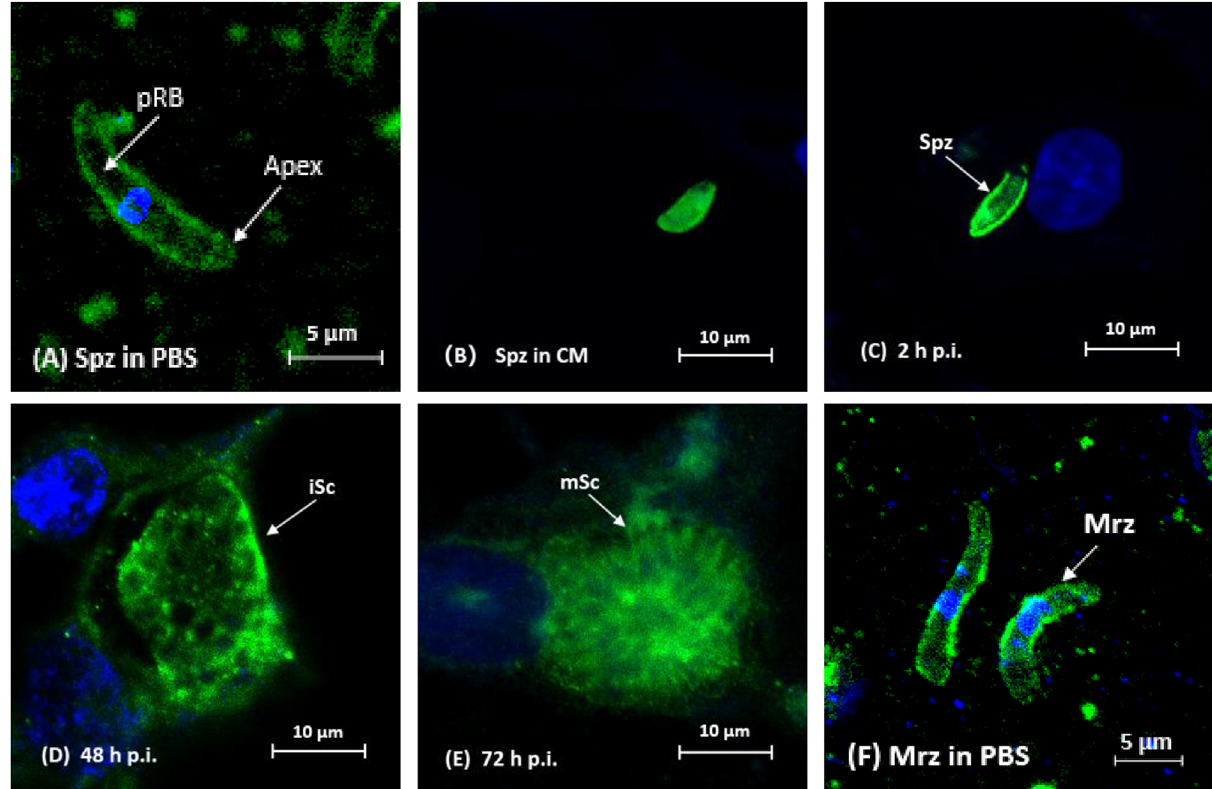
Figure 6. Localization of Et CHP18905 in infected DF-1 cells by indirect immuno fl uorescence. Parasites incubated with anti-r Et CHP18905, stained with FITC (green)-conjugated secondary antibodies, and counterstained with DAPI (blue). Infected DF-1 cells were collected at indicated time points post-infection. (A) Sporozoites (Spz) in PBS, pRB, posterior refractile body; (B) Spz in complete medium. Infected DF-1 cells were collected at the indicated time points post-infection (pi); (C) 2 hours pi (hpi); (D) immature schizonts (iSC) 48 hpi; (E) mature schizonts (mSC) 72 hpi; (F) merozoites (Mrz) in